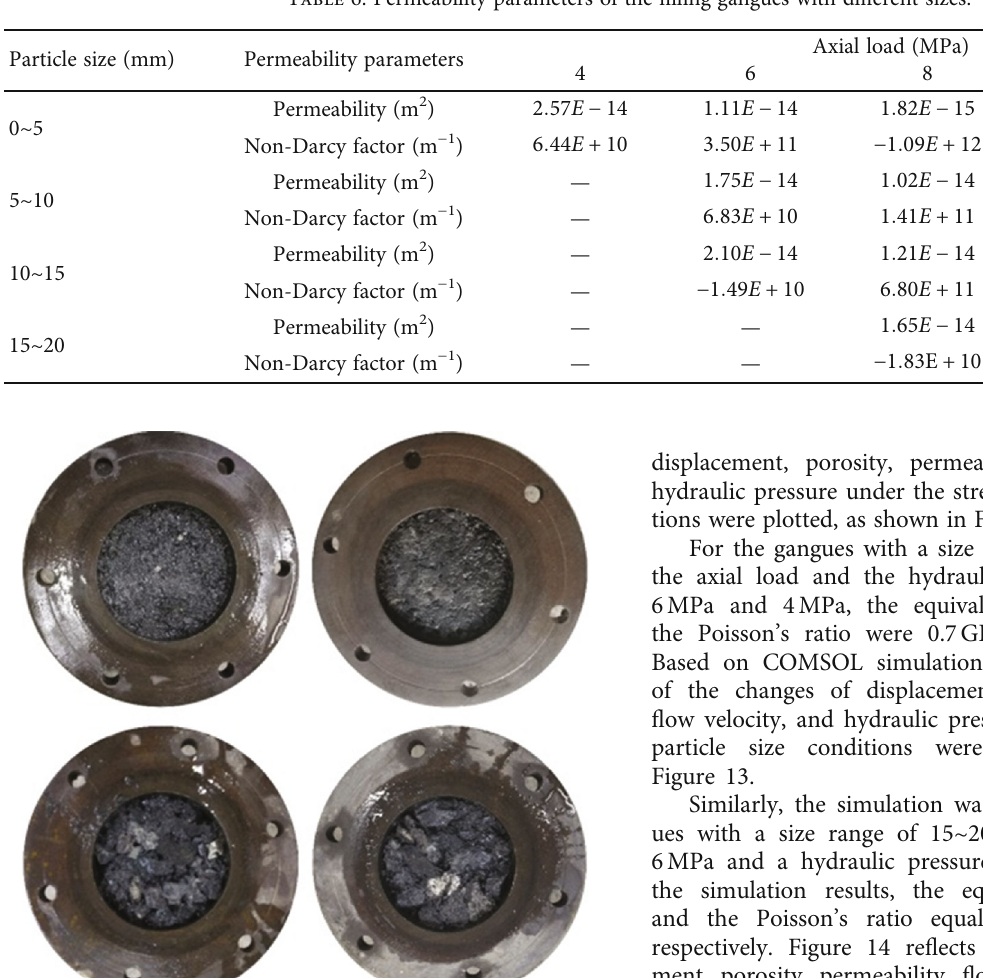
V of the fi lling gangues with a particle size of 0 ~ 5 mm at di ff erent axial loads: (a) 8 MPa and Figure 10: Fitted curves between G p and (b) 10MPa. Table 6: Permeability parameters of the fi lling gangues with di ff erent sizes.